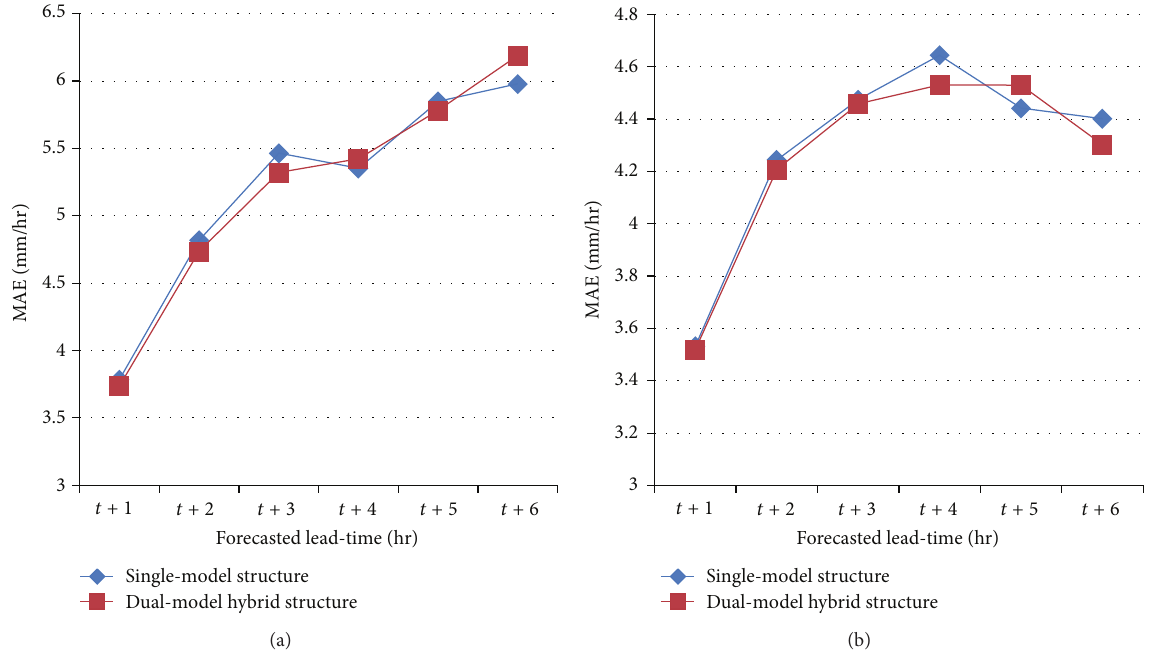
Figure 10: Comparison of the forecast performance of the single and hybrid ANFIS-based models at Hsia-Yun station: (a) validation; (b)